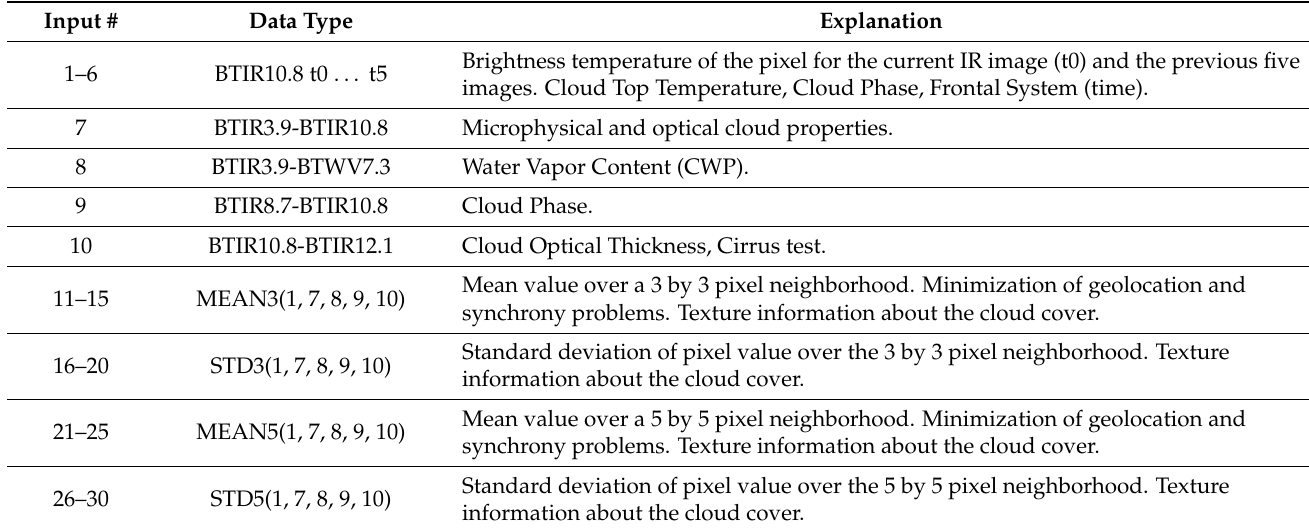
Table 4. Night time